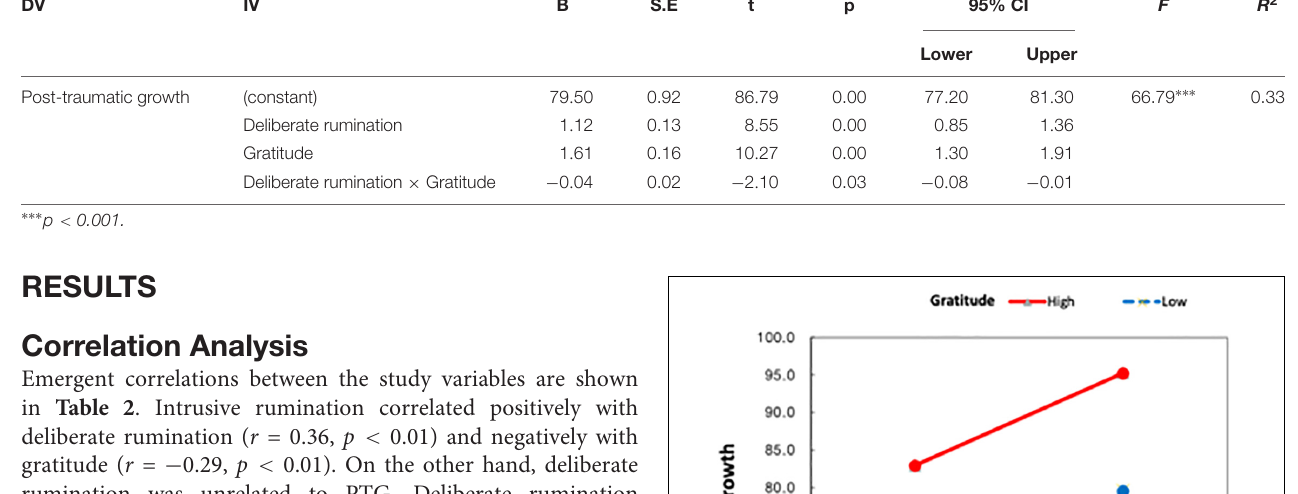
TABLE 5 | The moderating effects of gratitude on the relationship between intentional rumination and post-traumatic growth). DV IV B